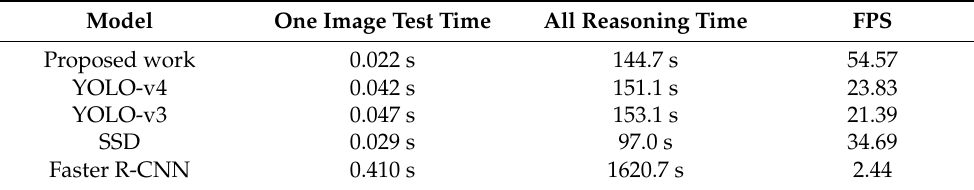
Table 6. Comparison of different models in test time, reasoning time, FPS.